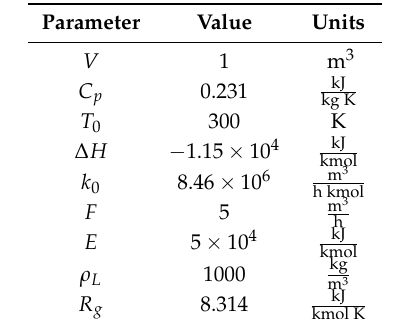
Table 2. CSTR process